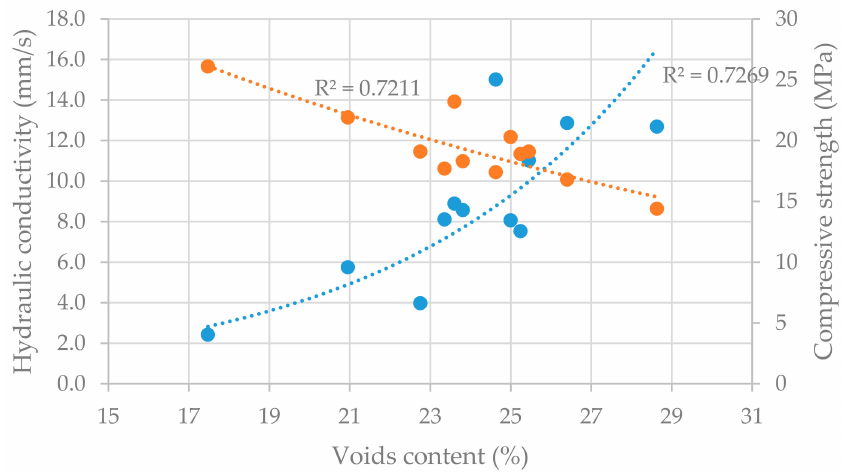
Figure 3. Interaction between hydraulic conductivity, void content, and the compressive strength of pervious concrete samples.